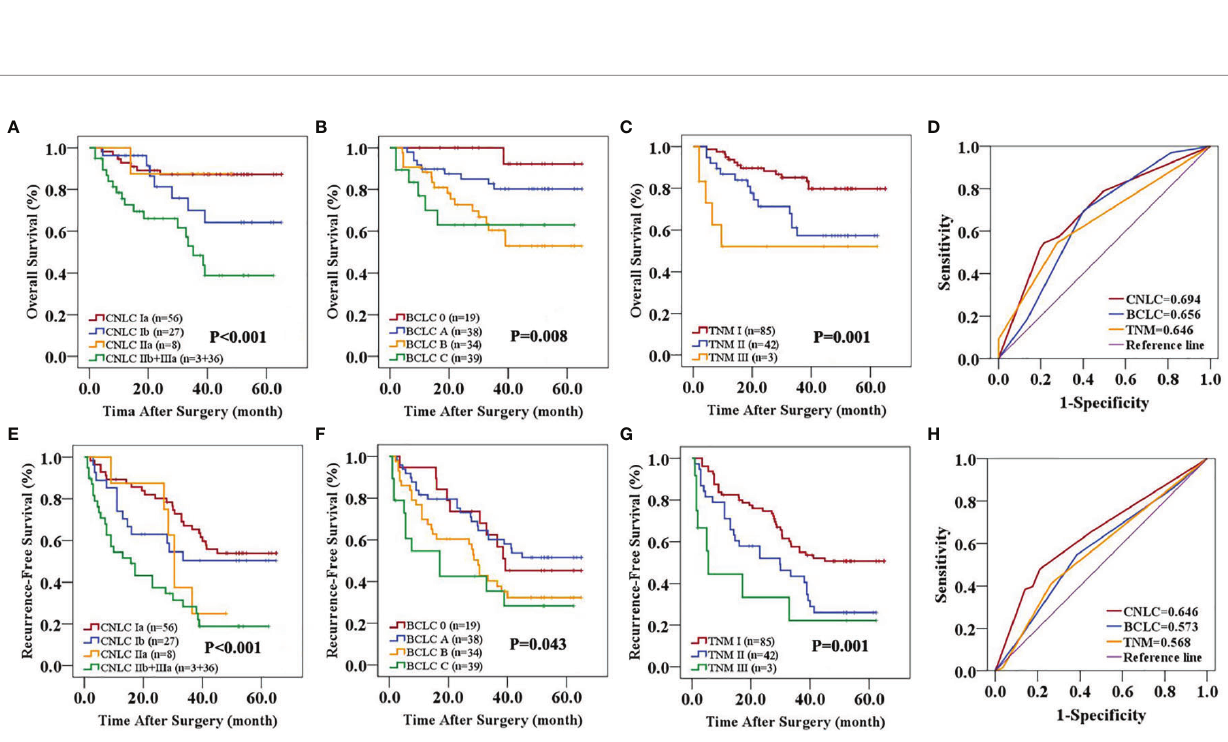
FIGURE 2 | Predictive accuracy comparison of the three staging systems for the prognosis of patients with HCC in the validation cohort. CNLC (A, E) , BCLC (B, F) and TNM 8th edition (C, G) staging systems are associated with OS (A – C) and RFS (E – G) of HCC after curative resection. ROC curves were used to compare the predictive accuracy of the three staging systems for assessing OS (D) and RFS (H) rates in the validation cohort.